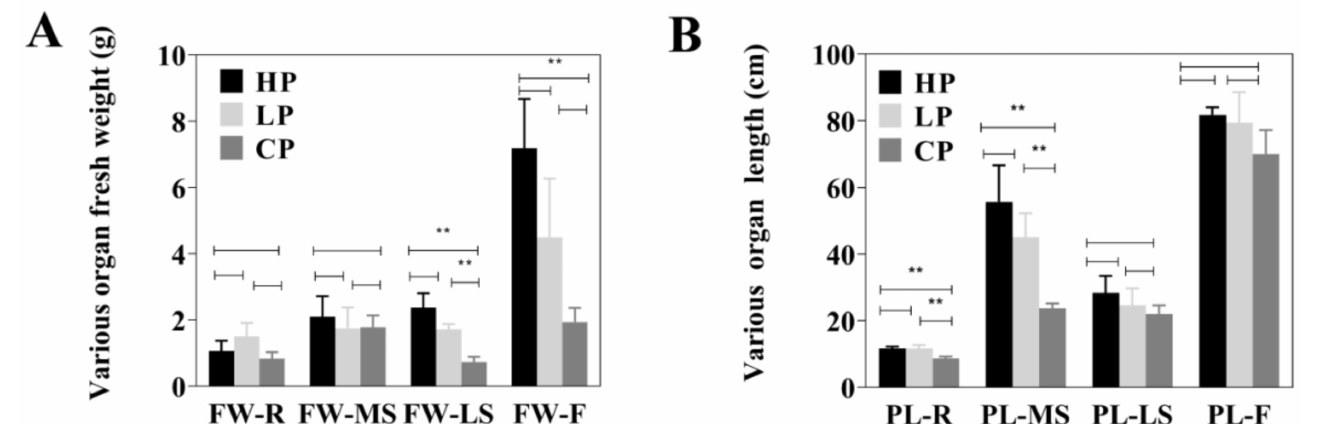
Figure 2. Growth performances of three concentrations of phosphorus fertilization. ( A ) Various organs fresh weight ( n = 3); ( B ) Various organs length ( n = 3). Three phosphorus fertilization levels: low phosphorus (LP), control group (CP) and high phosphorus (HP); and Four organs: root (R), main shoot (MS), lateral shoot (LS) and flower (F). FW: fresh weight; PL: plant organ length. ** represent p <